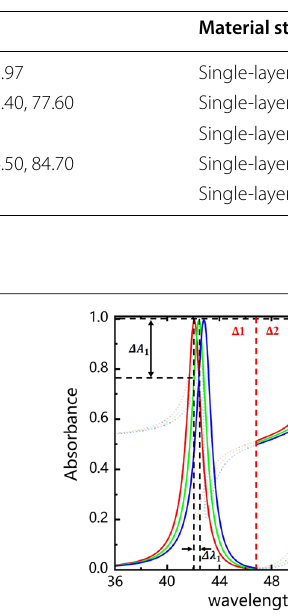
Fig. 5 Absorption spectrum and the phase shift diagram when the refractive index n sur is increased from 1 to 1.1 by a step of 0.05. Here, the discussed structure is Fig. 1a and other parameters are n d n sur 1 = Table 2 Parameters of the absorption, wavelength, phase